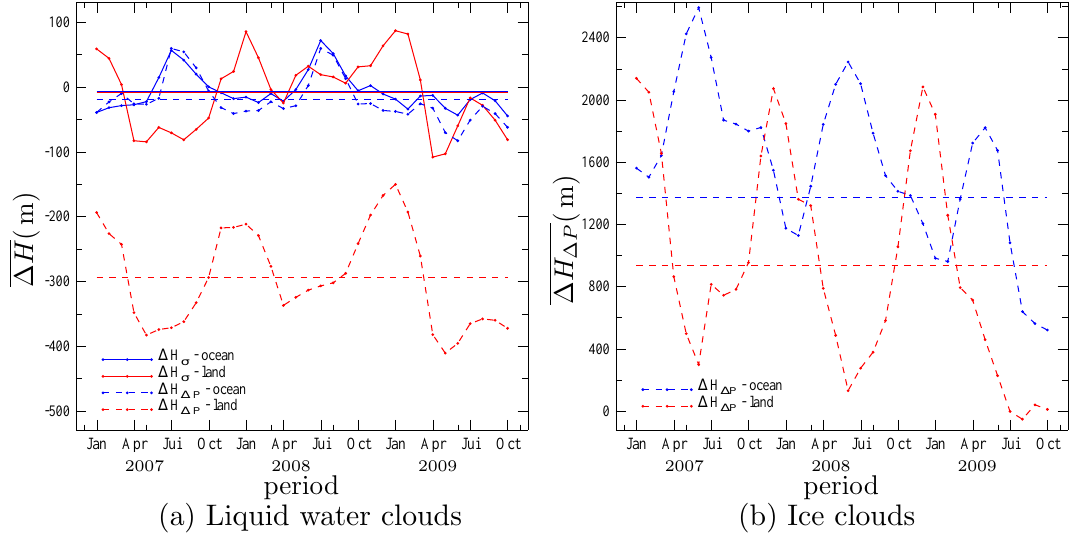
Fig. 13. Temporal evolution of the monthly average difference between CPR/CALIOP H and the POLDER retrieved H 1P and H σ from 2007 to 2009 for liquid water clouds (a) and ice clouds (b) . Solid lines are for 1H σ = H σ − H , and dashed lines for 1H 1P = H 1p − H : in blue over ocean, and red over land. The standard deviation is not represented as it stays close to 1000m (5000m) for liquid (ice) clouds all along the three years.